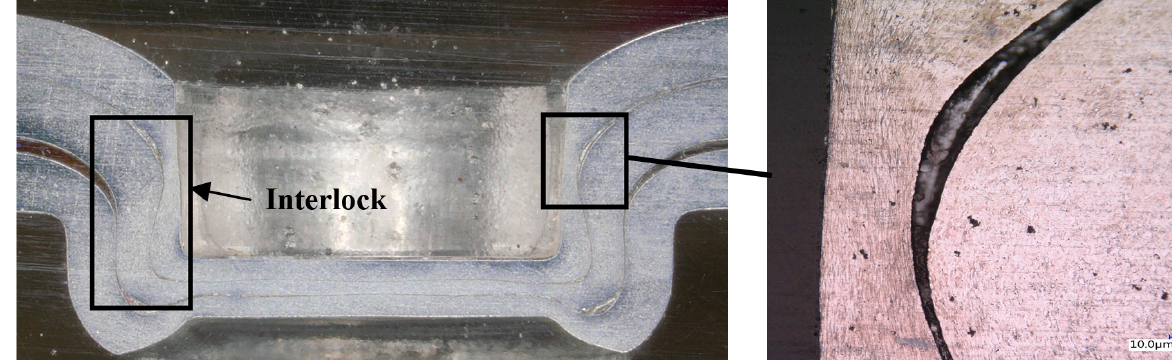
Figure 9: Areas of interlocking of clinched joints with H220PD steel sheet.